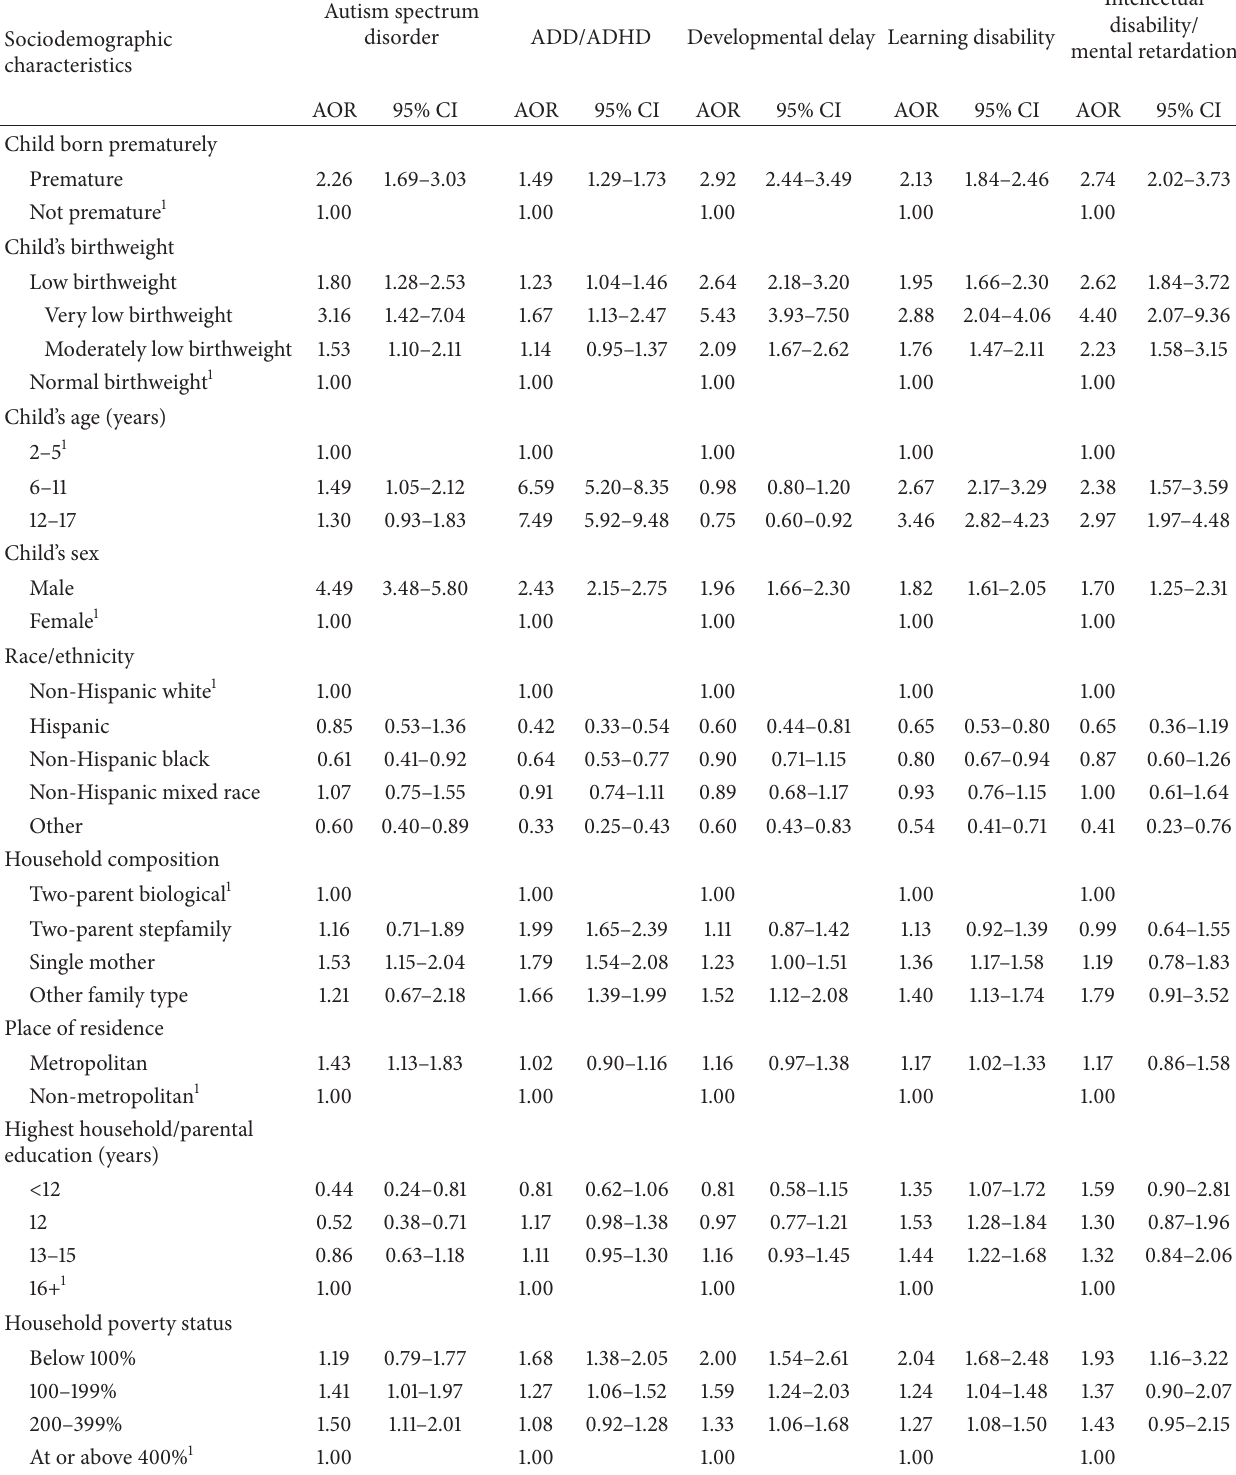
Table 6: Adjusted odds ratios (AOR) and 95% confidence intervals for selected mental-health-related conditions among US children aged 2–17 years by perinatal and sociodemographic characteristics: the 2011-2012 National Survey of Children’s Health ( 𝑁 =